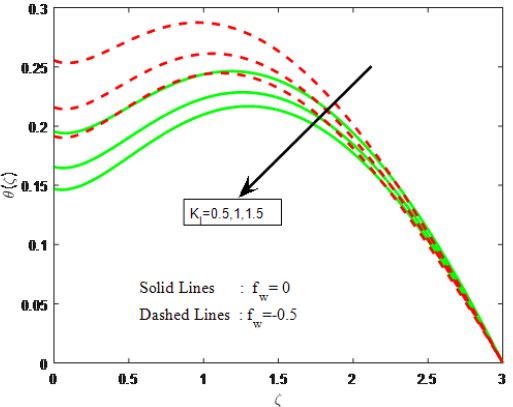
Fig. 16: The effect of Schmidt number ( Sc ) on velocity field